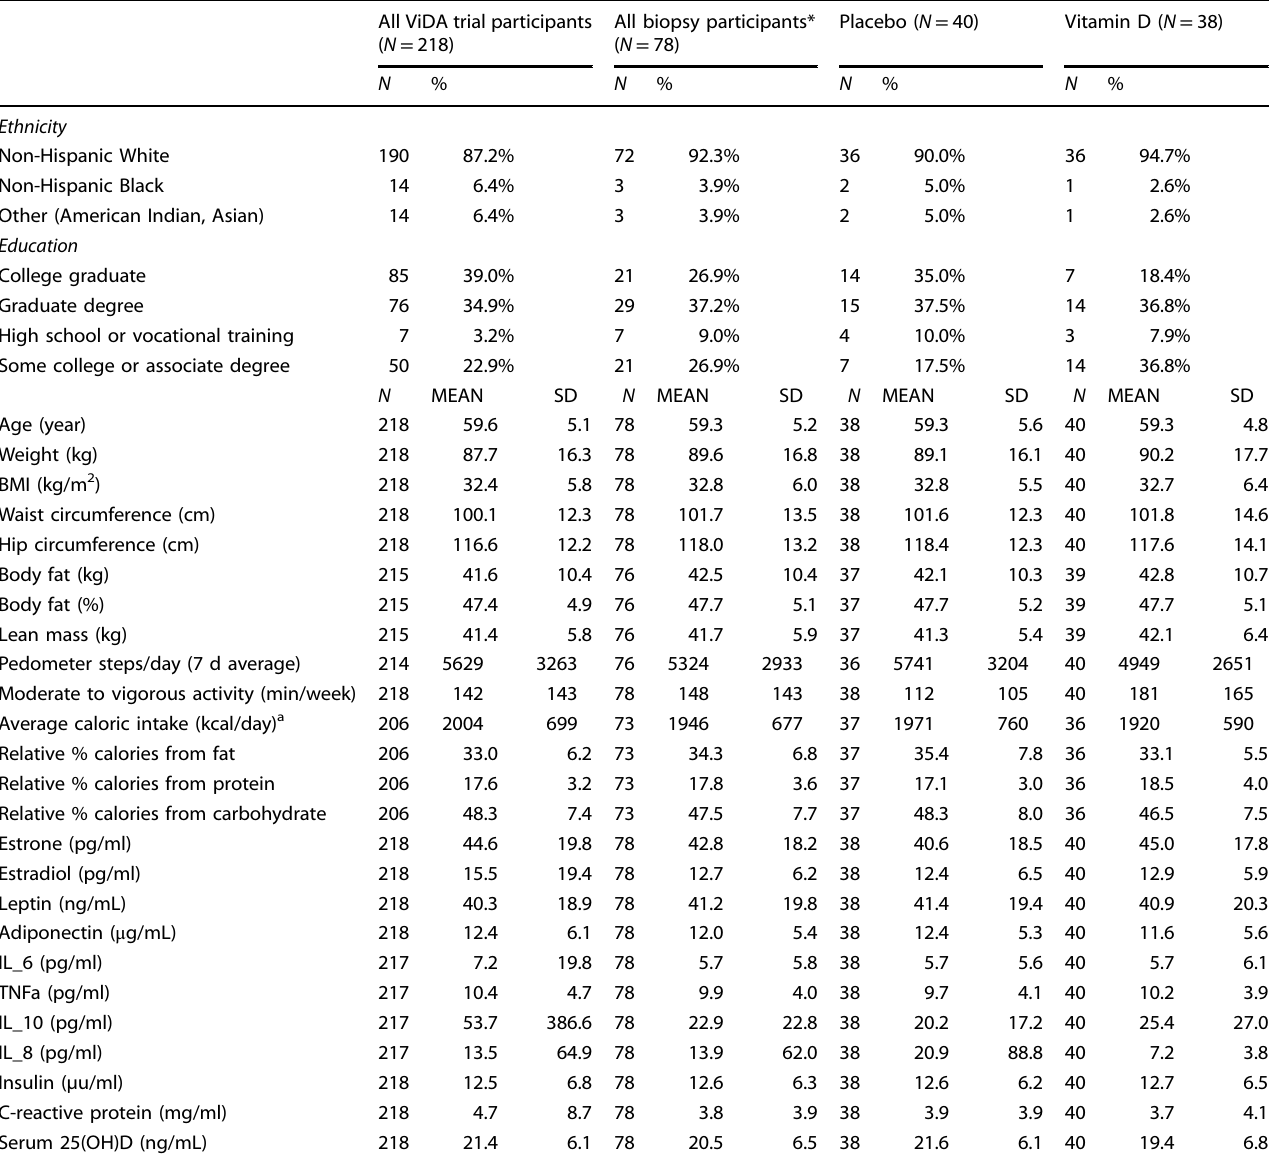
Table 1. Baseline characteristics of ViDA participants who consented to abdominal adipose biopsy (AB) and/or random fi ne needle periareolar aspiration